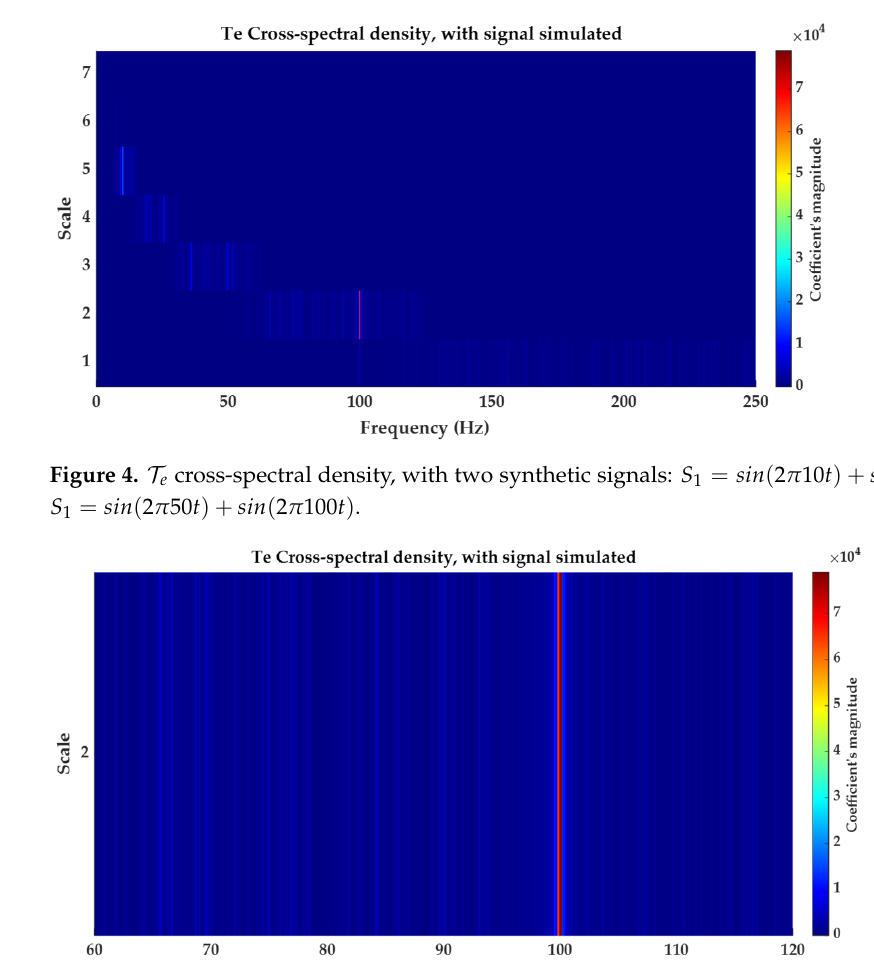
Figure 5. T e cross-spectral density in Scale 2, with two synthetic signals: S 1 = sin ( 2 π 10 t ) + sin ( 2 π 100 t ) and S 1 = sin ( 2 π 50 t ) + sin ( 2 π 100 t ) . Absolute error 1 ∗ 10 − 3 .